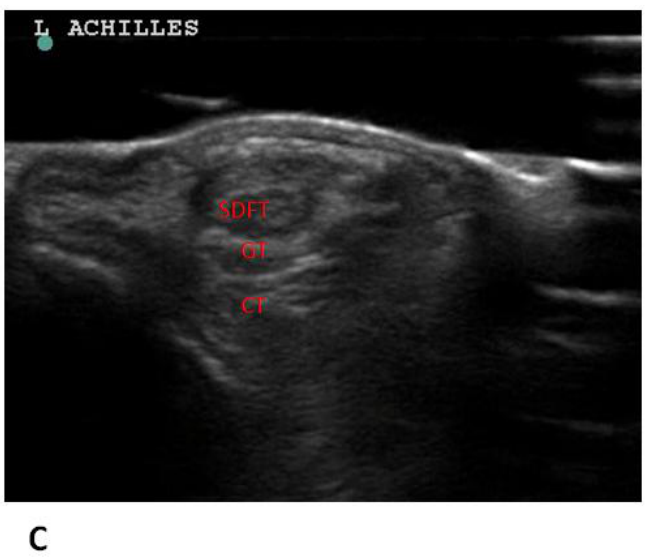
Figure 6C : Cross-sectional view of a normal Achilles tendon - distal Toward the distal part, the superficial digital flexor tendon (SDFT) moves to a more superficial position.